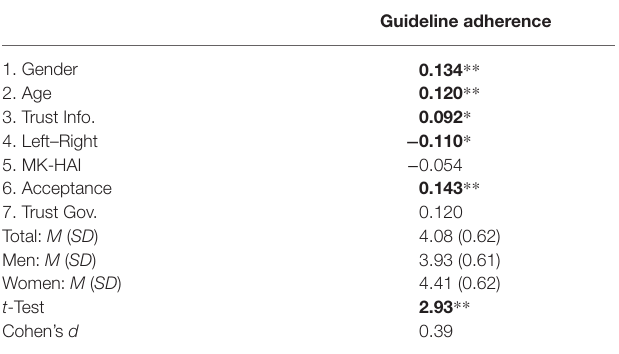
TABLE 6 | Means, SDs, and correlations for gender, age, trust in official information, political orientation, health anxiety, acceptance of the measures, and trust in the government with adherence to the social distancing guidelines in Study 2.